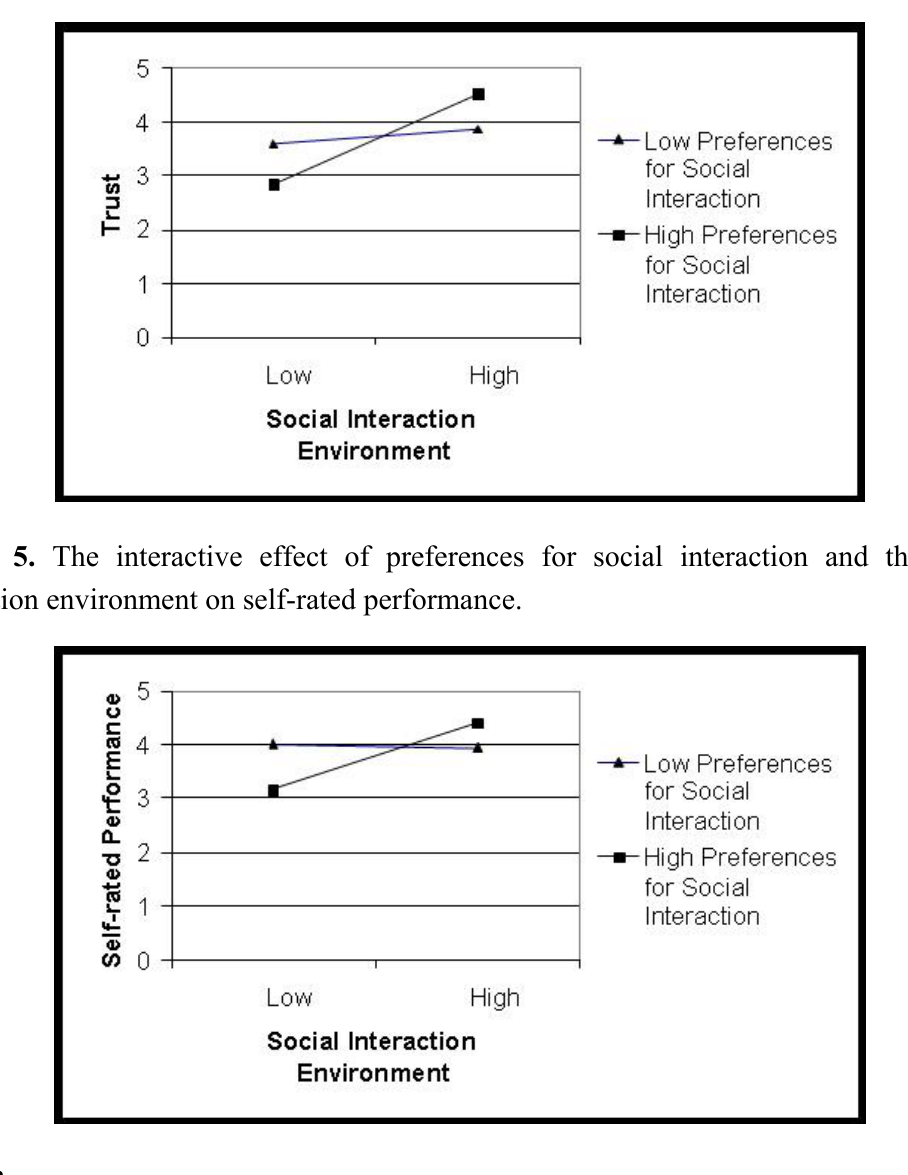
Figure 4. The interactive effect of preferences for social interaction and the social interaction environment on trust.